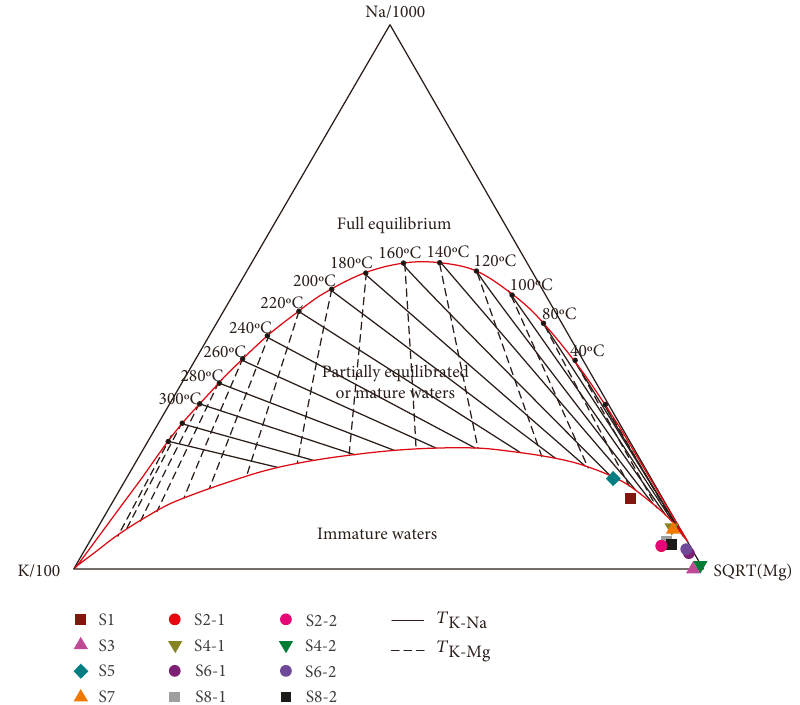
Figure 10: Na-K-Mg triangle diagram showing the hot spring water samples in the Simao Basin ( T is a set of isotherm according to the K-Mg K-Na geothermometer; T K ‐ Mg